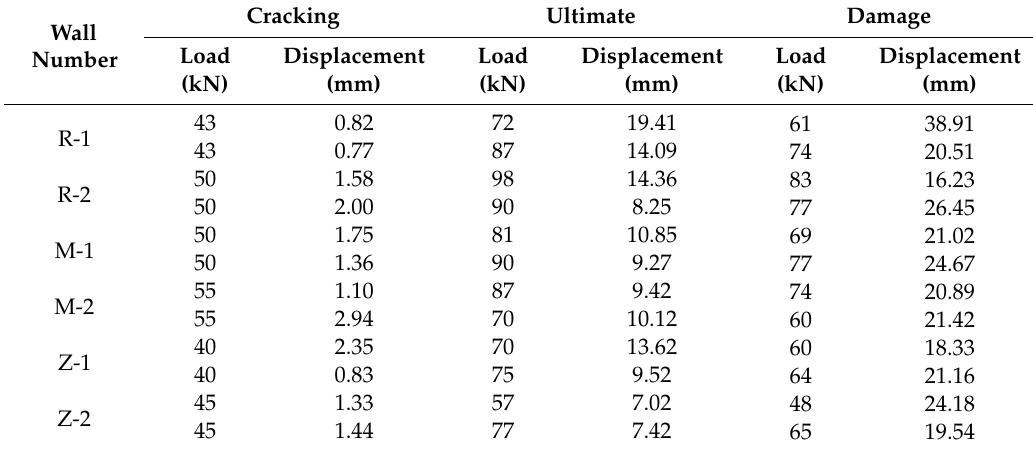
Table 2. Tested load and displacement at feature points of hysteretic curves (push and pull).